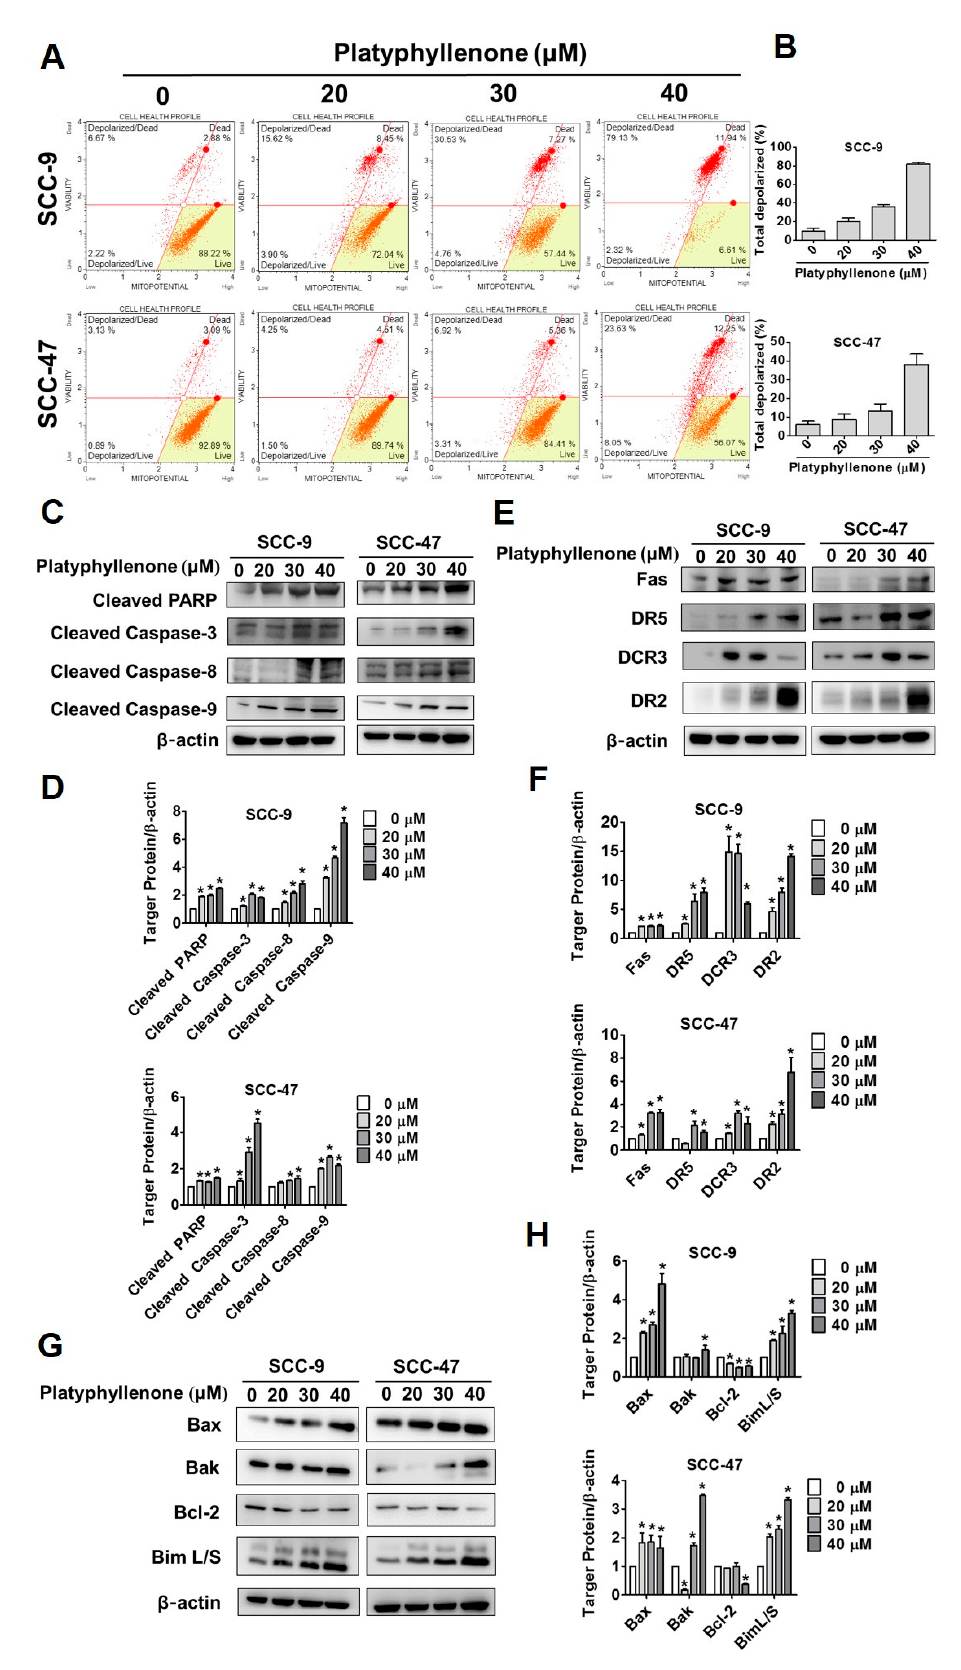
Figure 4. Platyphyllenone activates apoptosis via the mitochondrial and death receptor pathways and regulators of apoptosis-related proteins in oral cancer cells. ( A , B ) SCC-9 and SCC-47 cell lines were treated with different